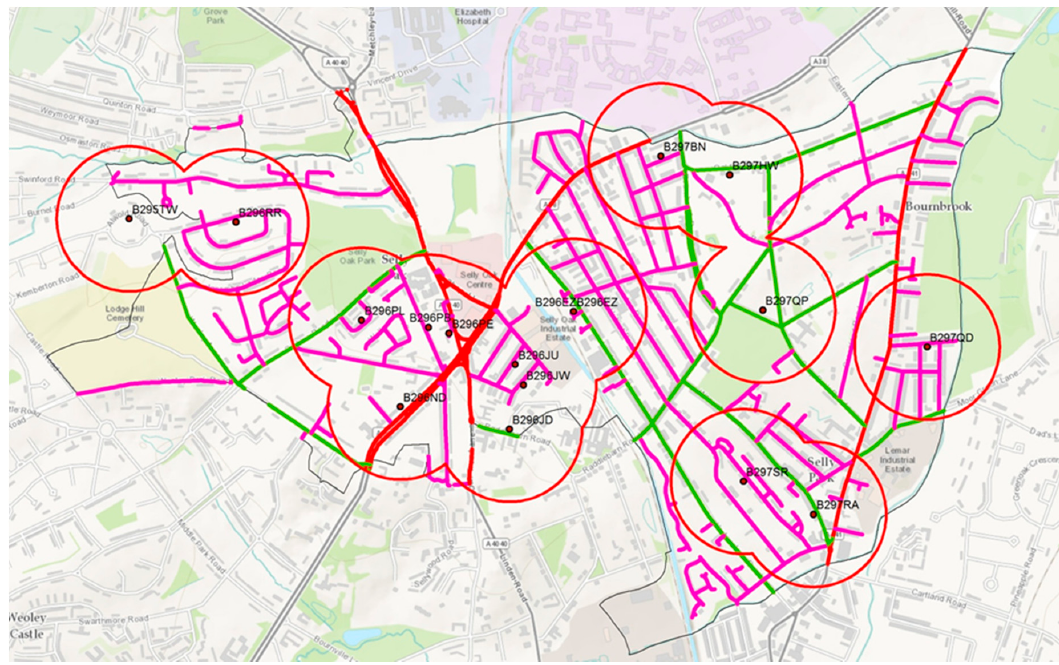
Figure 2. A selection of road sections (in purple, red, orange and green) for built environment audits that intersect the Selly Oak ward boundary. Red circles represent the 300 m buffer zones around postcodes, obtained from questionnaire respondents. Source: Author.